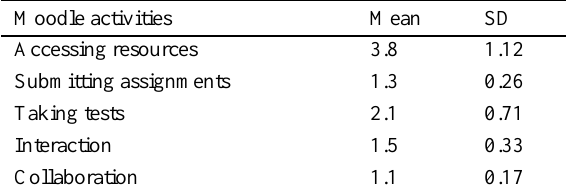
Table 1. Students usage of Moodle via smart mobile phones.